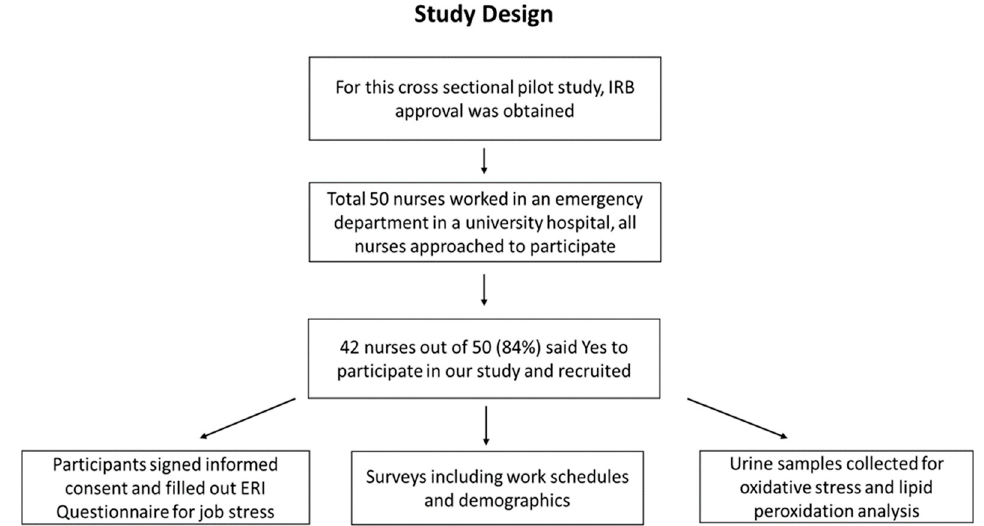
Figure 1. A flow diagram showing the study design. This study design was adopted